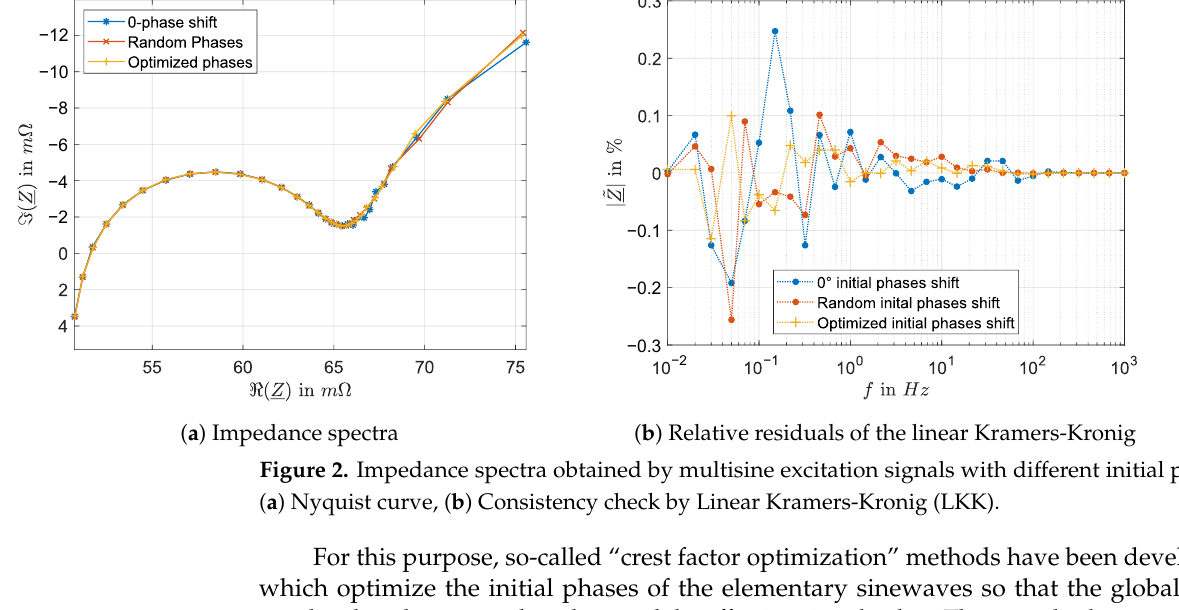
( b ) Relative residuals of the linear Kramers-Kronig Figure 2. Impedance spectra obtained by multisine excitation signals with different initial phases: ( a ) Nyquist curve, ( b ) Consistency check by Linear Kramers-Kronig